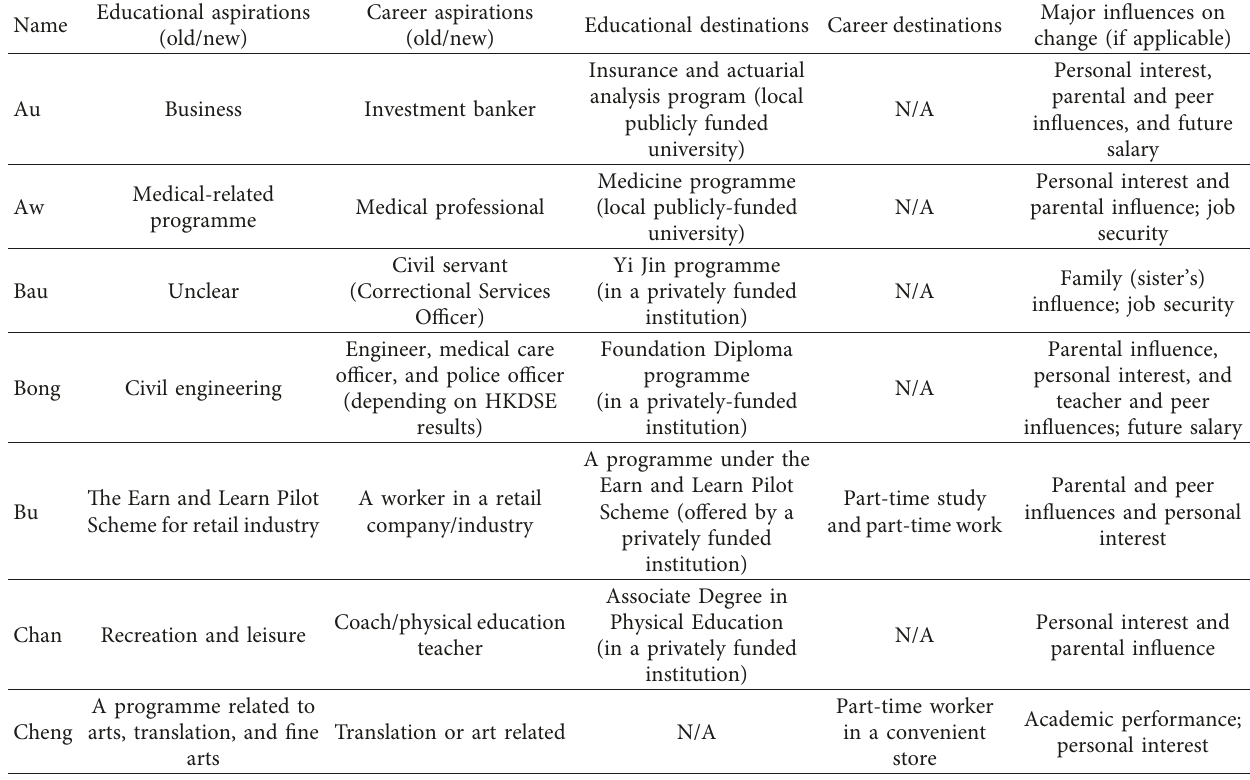
Table 2: Academic and career aspirations and destinations of students (during the period of